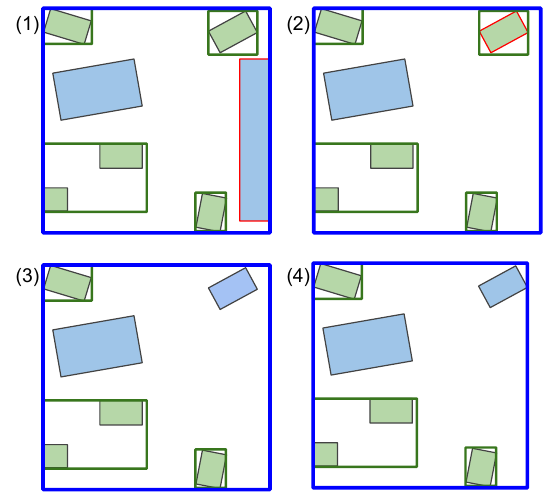
Figure 6: Removal procedure. (1) Feature to remove (red border). (2) Find lowest weight child feature (red border). (3) Remove lowest weight child feature from child tile and add it to current tile. (4) Recompute bounding